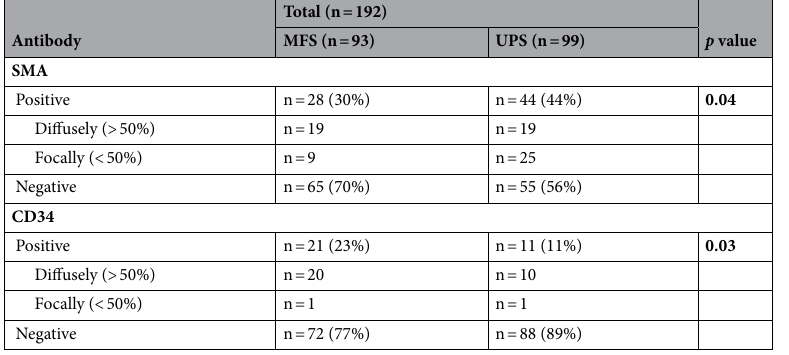
Table 2. Immunohistochemistry. Bold values indicate p < 0.05